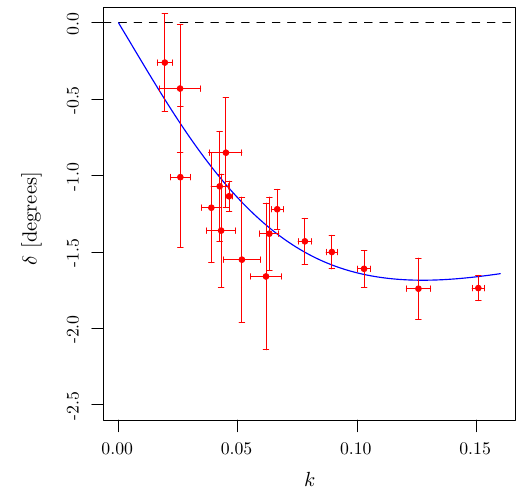
Fig. 6 Phase shift as a function of the scatteringmomentum k in lattice units. The expected curve, given by the parameters from the best fit to (cid:7) E 2 , is shown as a solid line